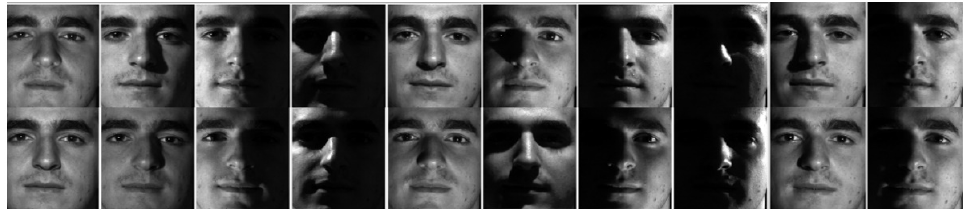
Figure 3. Samples from the Extended Yale B dataset.